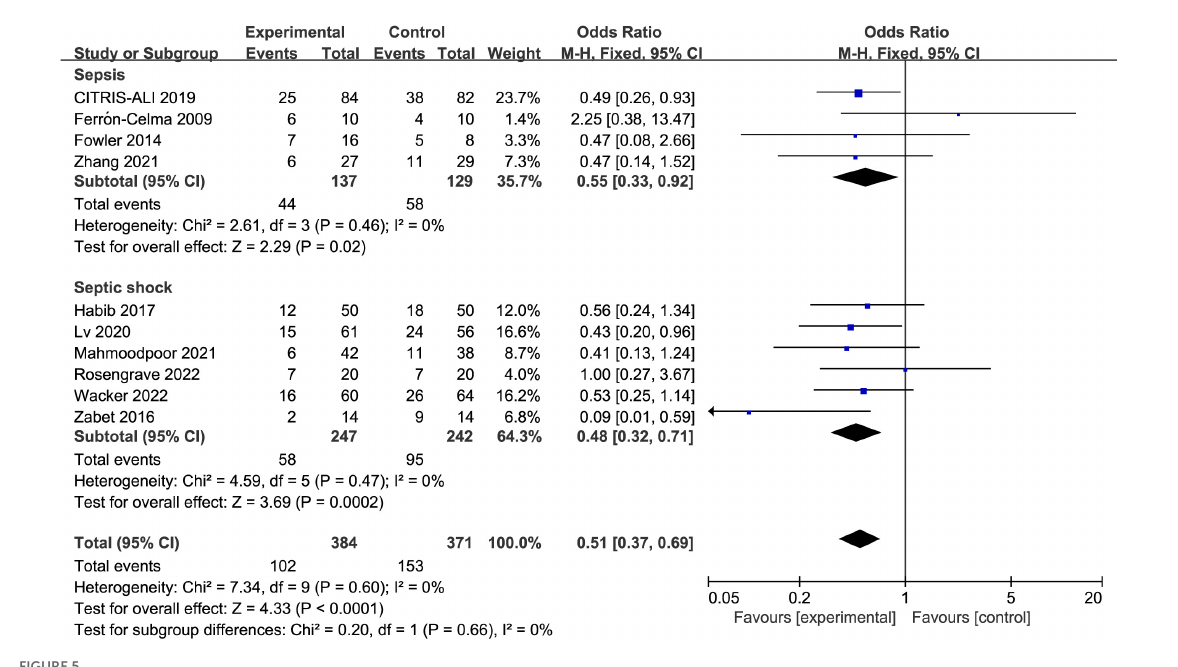
FIGURE5 Forest plot showing the subgroup analysis of short-term mortality, patients with sepsis vs. patients with septic